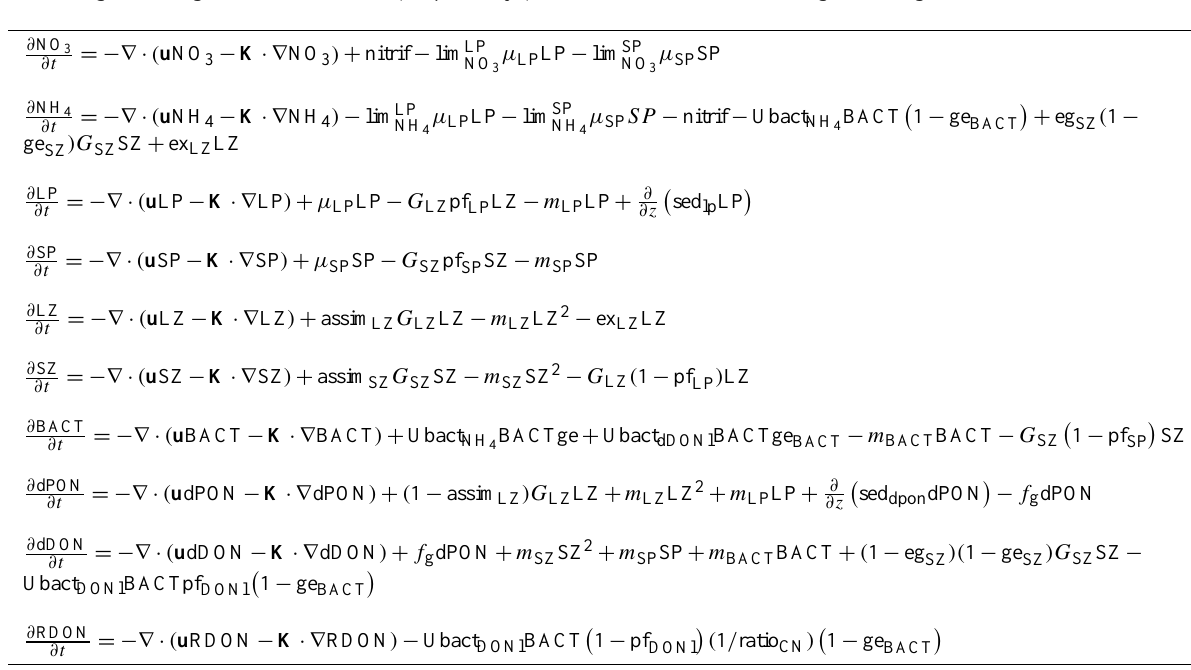
Table 1. Differential equations for the 10-component biogeochemical model: nitrate (NO 3 ) , ammonium (NH 4 ) , large and small phytoplank- ton (LP and SP, respectively), large and small zooplankton (LZ and SZ, respectively), bacterioplankton (BACT), detrital particulate and dissolved organic nitrogen (dPON and dDON, respectively), and usable riverine dissolved organic nitrogen